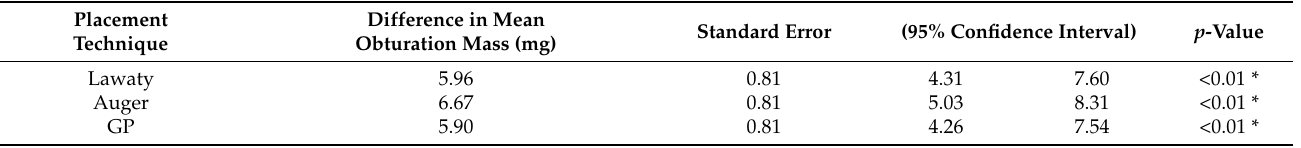
Table 1. Results of estimated differences in mean obturation times (95% confidence intervals) with the plugger group set as the reference group. Placement